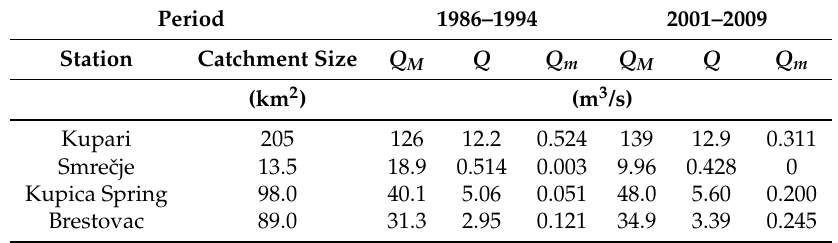
Table 1. Catchment size, the average values of maximum flows Q M , mean daily flows Q and minimum flows Q m in the 1986–1994 and the 2001–2009